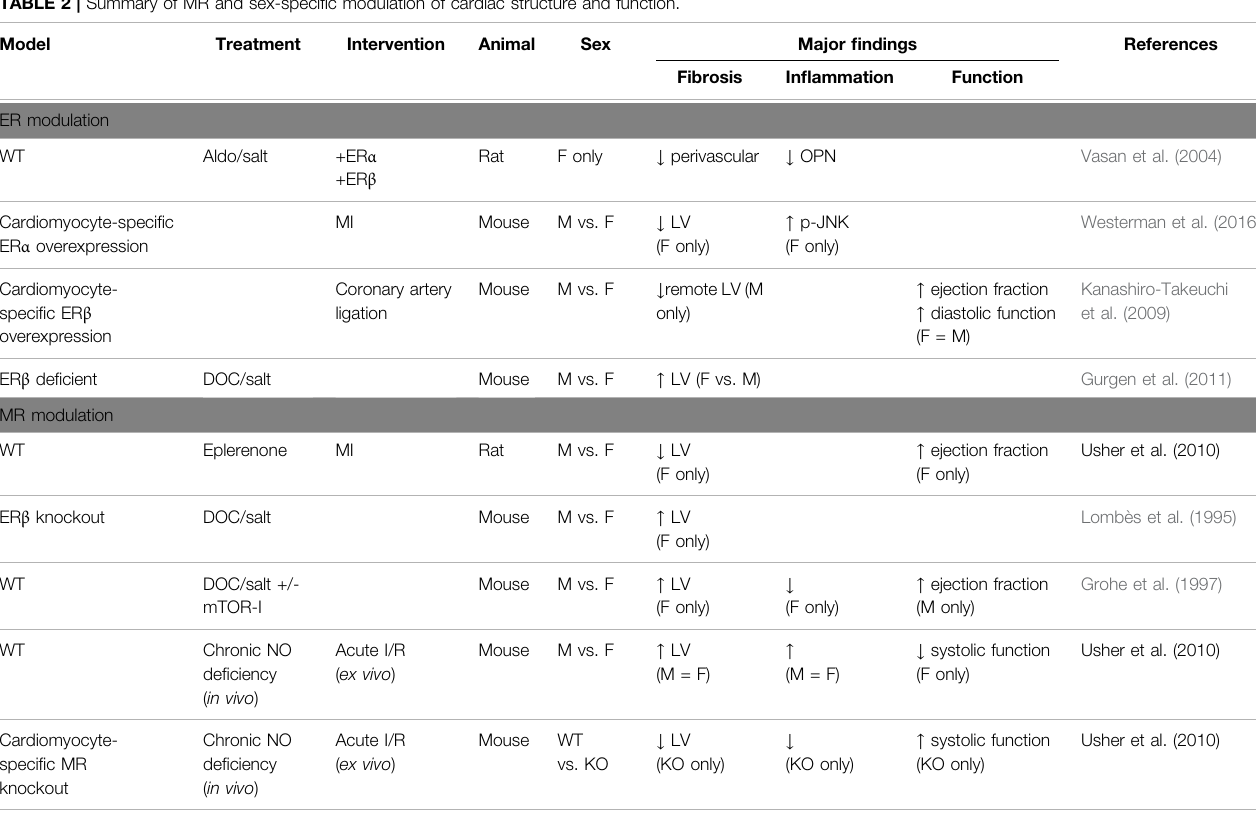
TABLE 2 | Summary of MR and sex-speci fi c modulation of cardiac structure and function.